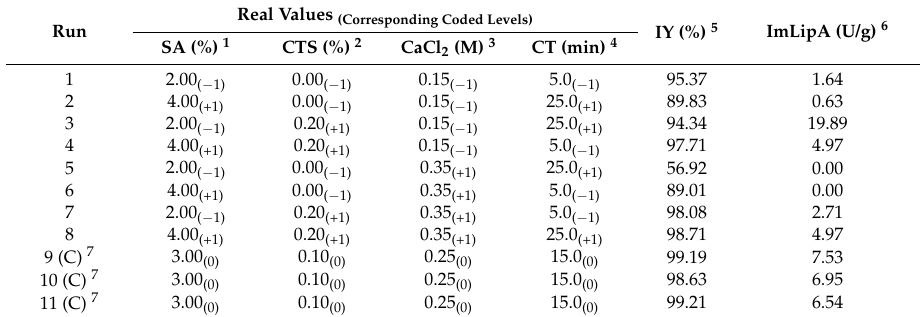
Table 1. Matrix of experimental runs for fractional factorial design (FFD) to evaluate immobilization yield and immobilized lipase activity.